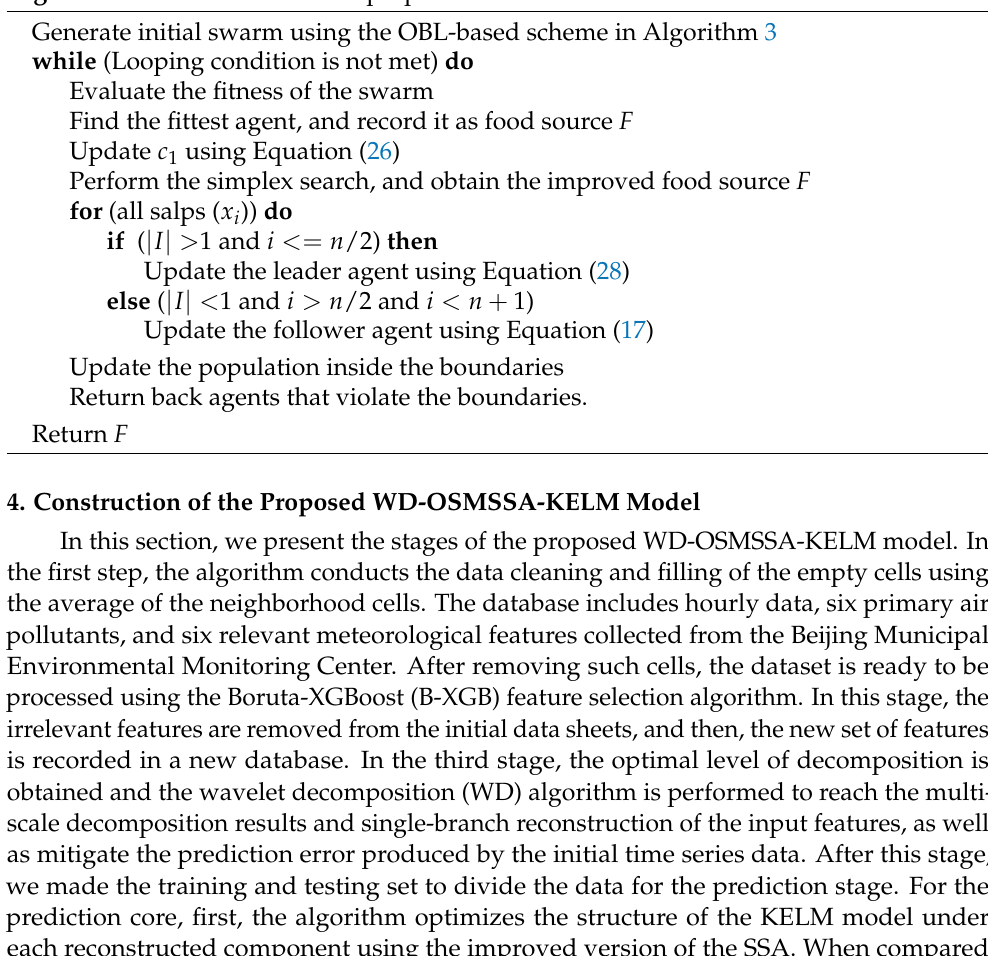
Algorithm 4 Pseudo-code of the proposed